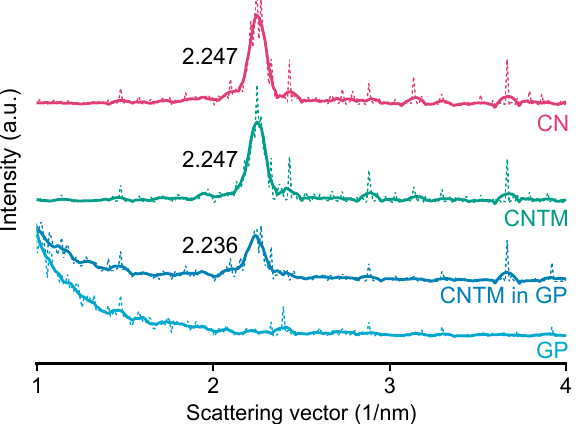
Figure 3. SAXS patterns of different nanodispersions and hydrogel beads at 20 °C. The values state the peak positions (q) upon which the calculation of the d-spacings was based. Abbreviations: CN—cholesteryl nonanoate, CNTM—cholesteryl nonanoate–trimyristin, GP—gel particle.